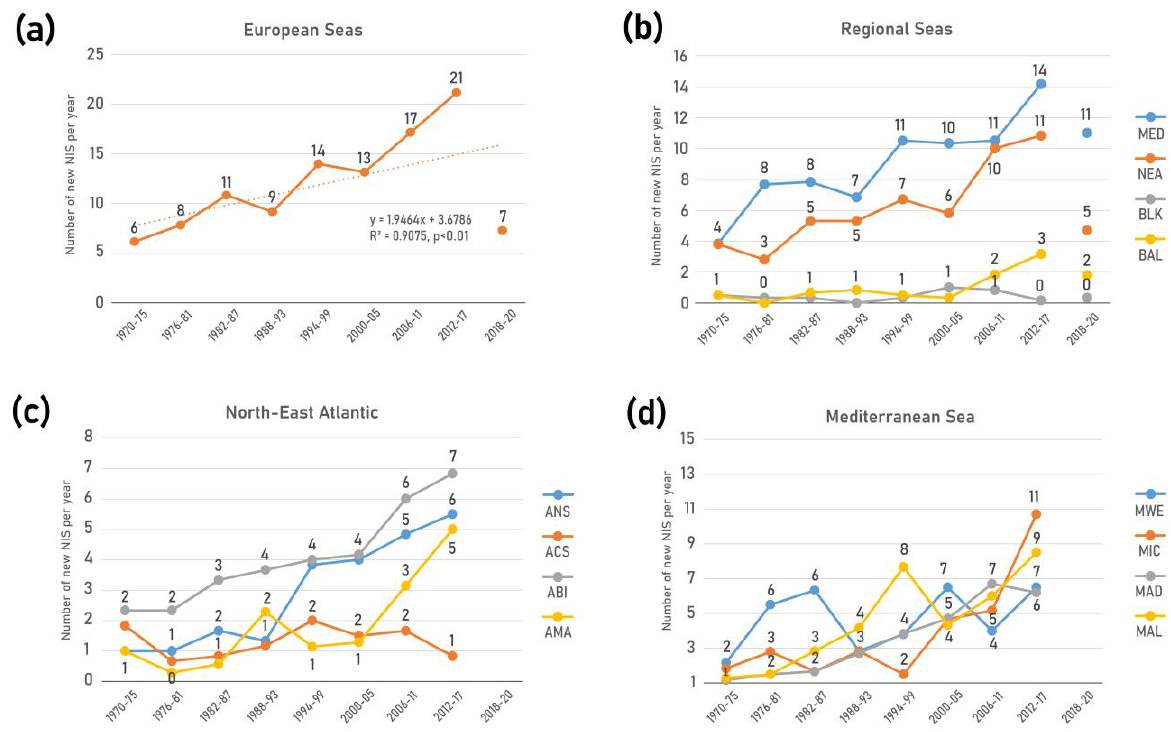
Figure 4. Annual rate of NIS introductions (6-year average) at different geographic levels: ( a ) European waters; ( b ) regional seas, ( c ) North-East Atlantic subregions: ABI = Bay of Biscay-Iberian Shelf, ACS = Celtic Seas, ANS = Greater North Sea, AMA = Macaronesia ( d ) Mediterranean subregions. MWE = Western Mediterranean, MIC = Central Mediterranean, MAD = Adriatic Sea, MAL = Eastern Mediterranean. Dotted line for the EU trend (Figure 4a) is a linear regression line. Note that the annual average for the final interval has been calculated for three years only.